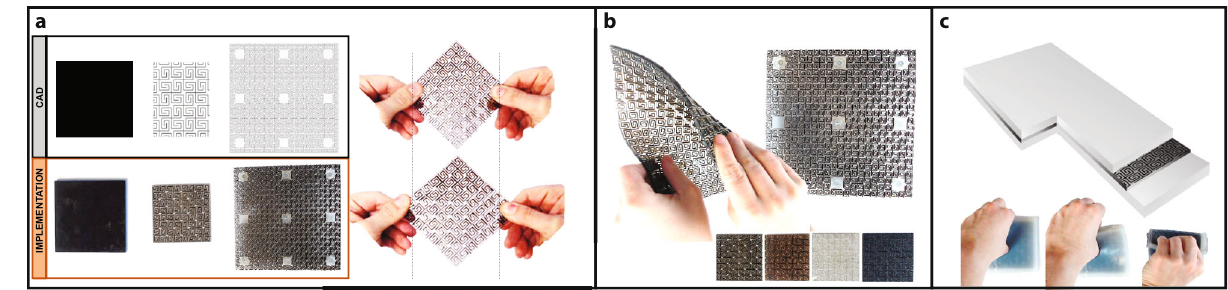
Fig. 2 Building the auxetic surface. a The pattern chosen was a repeating spiral pattern 45 , the fi rst of a recently explored class of Archimedean spirals that can be used to give double curvature to a fl at sheet 46 . Compared to other patterns, this pattern fi lls the majority of the surface area and provides good support to the surface. Each spiral occupied 1 cm 2 . b Experimentation with a variety of materials including wood, polycarbonate, and acrylics of different